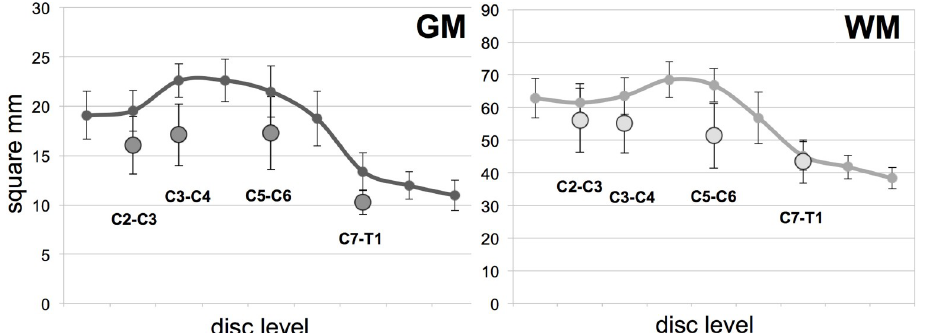
Fig 3. Spinal cord gray (GM) and white matter (WM) areas of all 10 motor neuron disease (MND) patients and healthy controls. Average GM (left) and WM area (right) of the 10 MND patients at the four cervical levels (circles) compared to 10 healthy controls (solid line, data from Papinutto 2015[28]). Whiskers represent standard deviations.